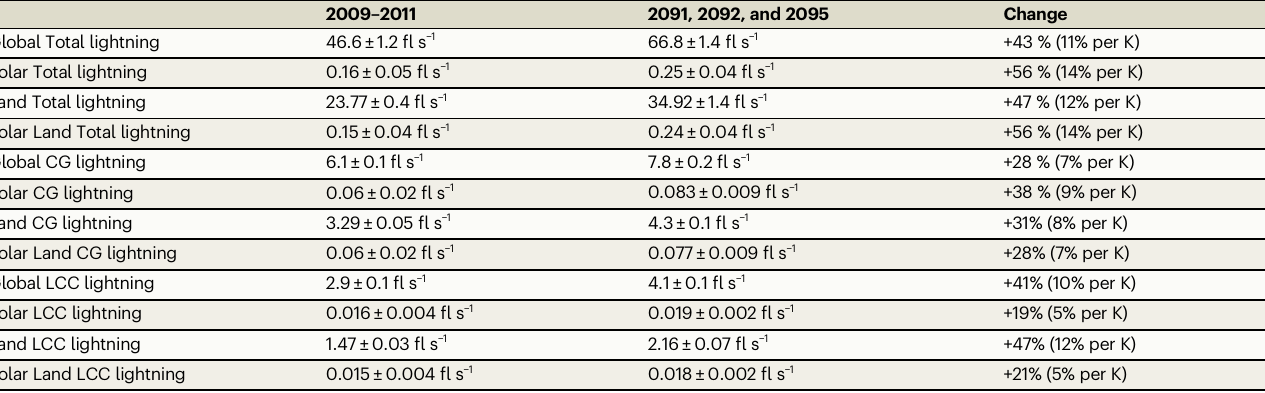
Table 1 | Total lightning, CG lightning and LCC lightning fl ash occurrence simulated for present day and the RCP6.0